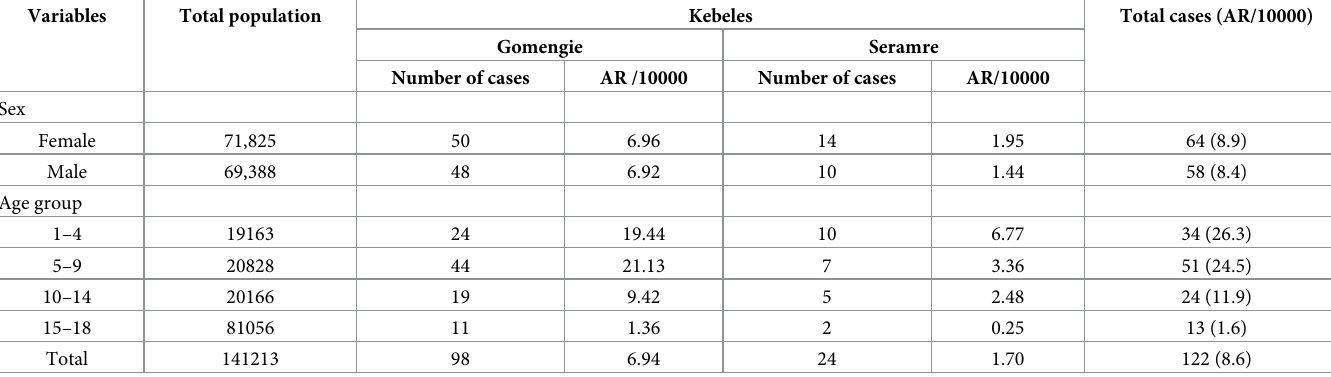
Table 1. Attack rate of pertussis cases in Gomengie and Seramre Kebeles of Dahena district, April 2019.